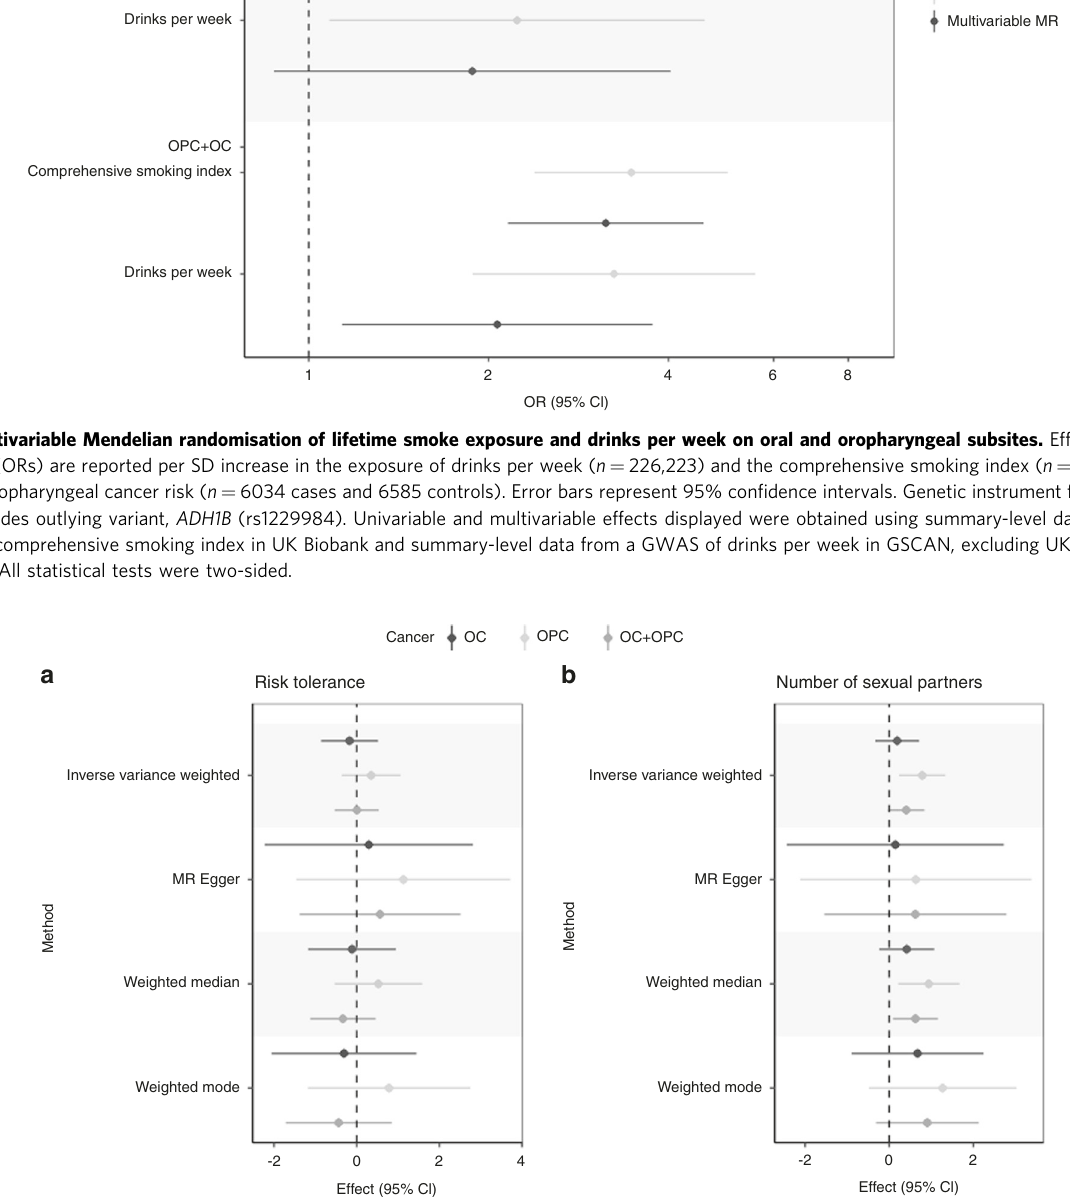
Fig. 4 Univariable Mendelian randomisation of risk tolerance and number of sexual partners on oral and oropharyngeal cancer subsites. Effect estimates (log odds) are reported per SD increase in ( a ) risk tolerance ( n = 508,782) and ( b ) number of sexual partners ( n = 370,711). There was some evidence for a causal effect of number of sexual partners speci fi c to the oropharyngeal subsite. Error bars represent 95% con fi dence intervals. All statistical tests were